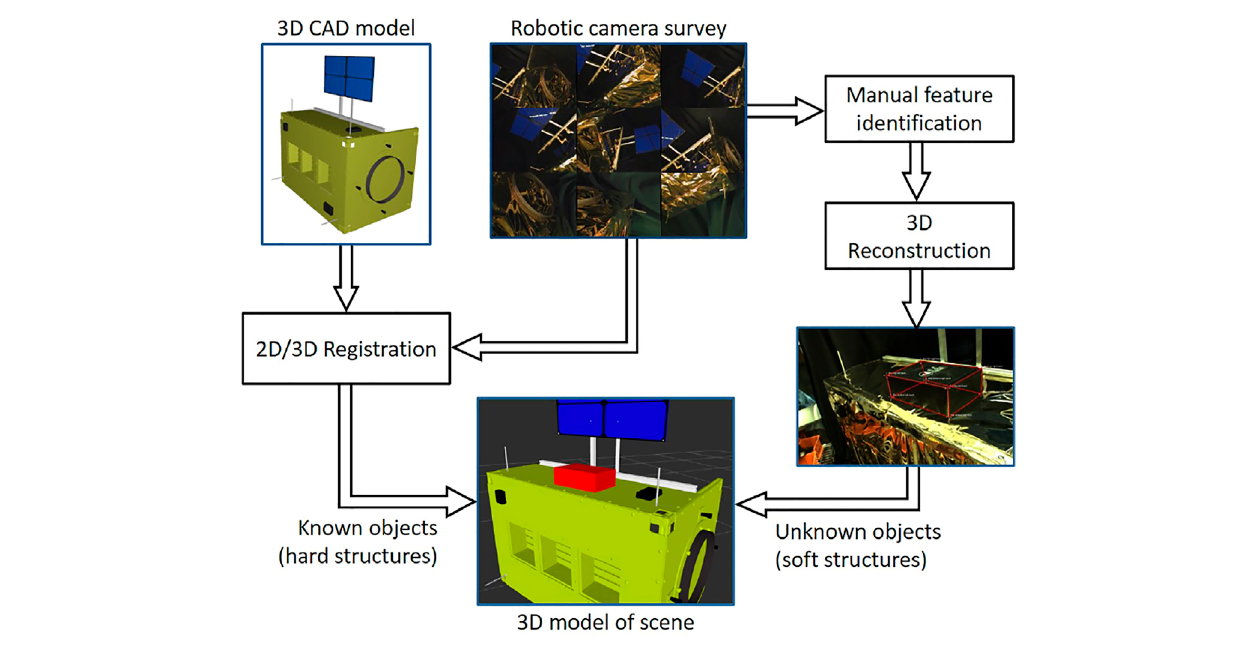
FIGURE 3 | Creating an environment model from a robotic 2D image survey by registering to known objects (satellite) and reconstructing unknown or imprecisely known objects (MLI hat).